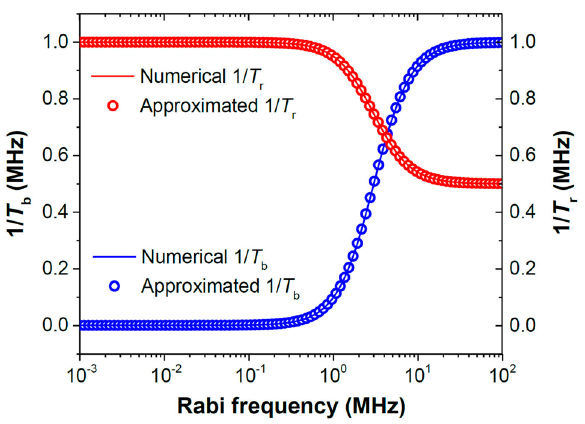
Figure 7. Single spin Rabi damping under the influence of external MW with T 1 = 1000 μs, T 2 = 1 μs, and δ/ 2 π = 3 MHz . The left axis (blue) represents the baseline decay rate constant 1 / T b and the right axis (orange) represents the oscillatory amplitude decay rate constant 1 / T r . Solid curves: numerical calculations; Open circles: calculations from Eqs. (11) and